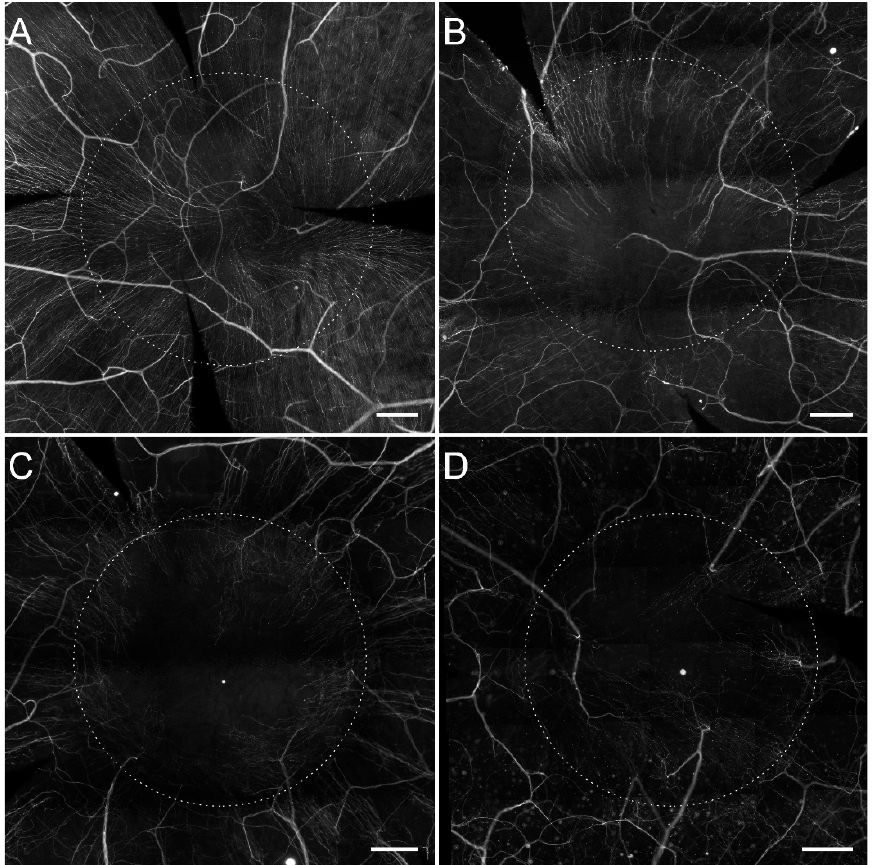
Figure 5. Nerve regeneration in whole-mount preparations of the cornea. ( A ) Example of an uninjured cornea showing intact β -tubulin III + corneal sensory innervation with a dense subbasal plexus. ( B ) HSmP-treated corneas showed higher numbers of regenerating axons in the ablated zone (dashed line) than Dx ( C ) and BSS ( D ) groups. Furthermore, regenerating fibers in the HSmP group reached a greater distance from the edge of the lesion (scale bars: 200 µm).